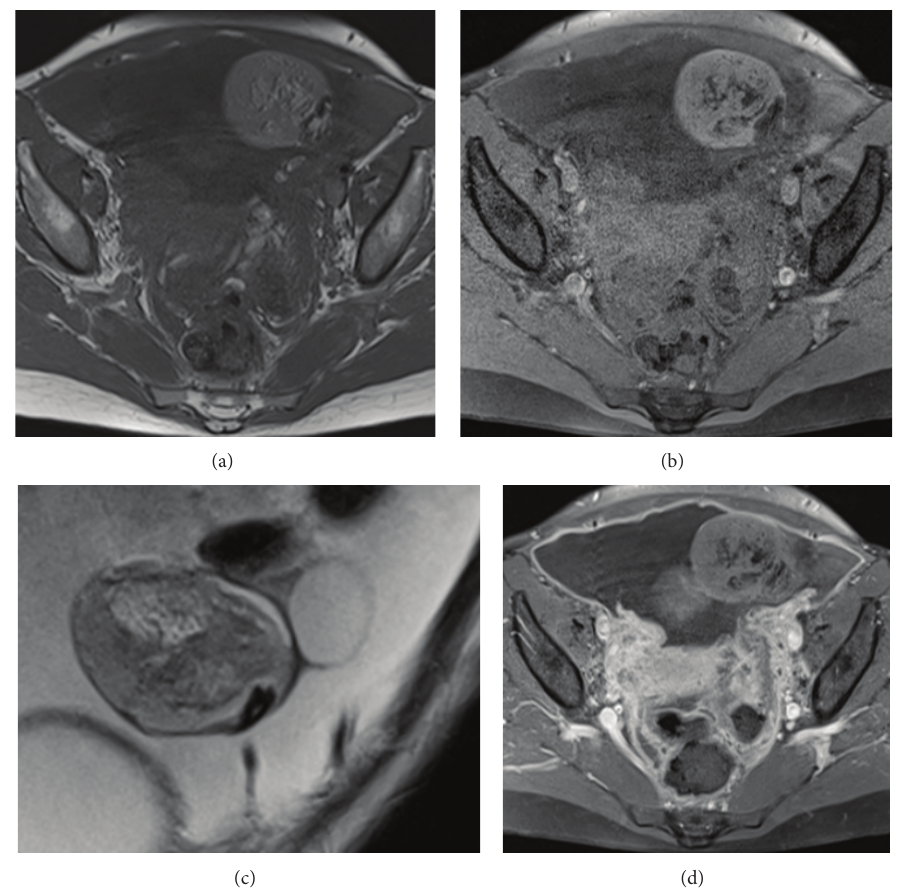
Figure 1: Axial T1 weighted (a) and with fat saturation (b). Images show a large heterogenous left ovarian mass measuring with fatty, solid, and liquid contents and a small calcification on coronal T2 weighted image (c) suggestive of cystic teratoma. Axial T1 postcontrast image (d) demonstrates ascites with peritoneal